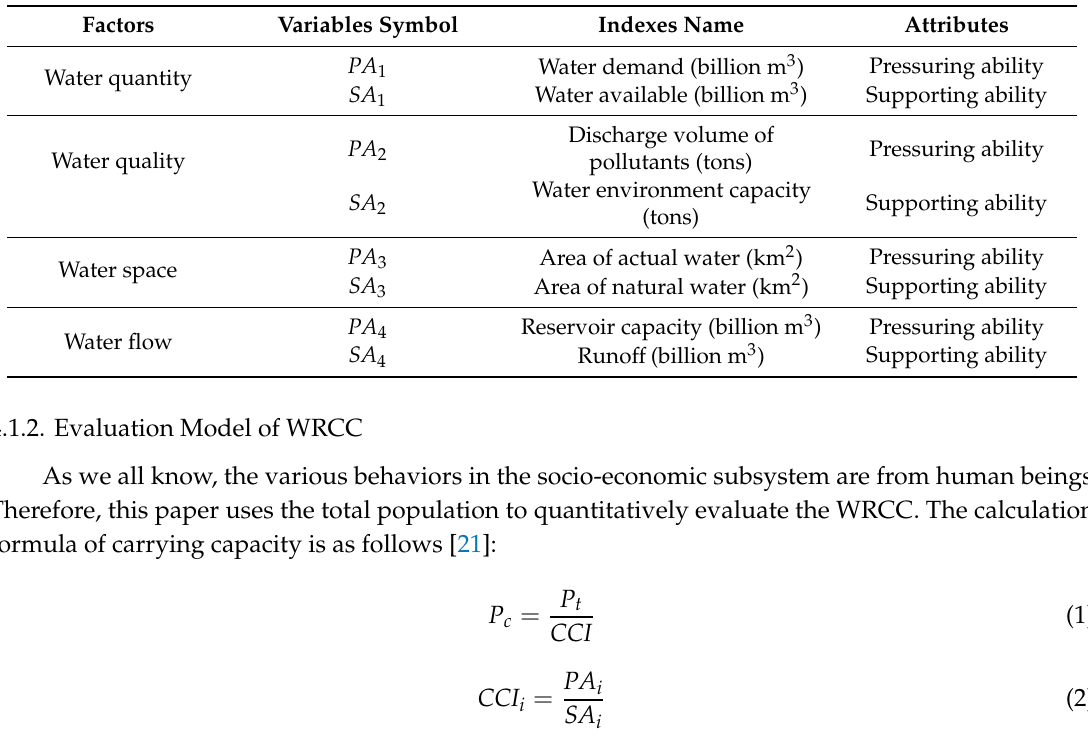
Table 2. The index system for water